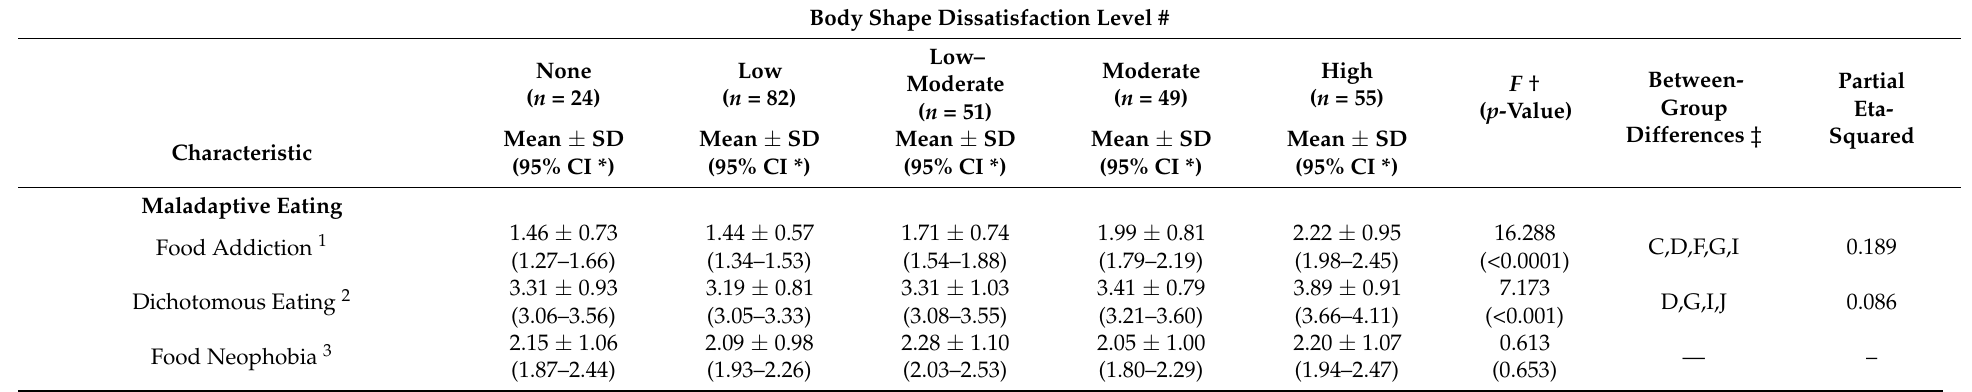
Table 2. Associations of Eating of Styles, Weight-Related Behaviors, and Health Status with Body Dissatisfaction Level Among Young Adult Women College Students (N =